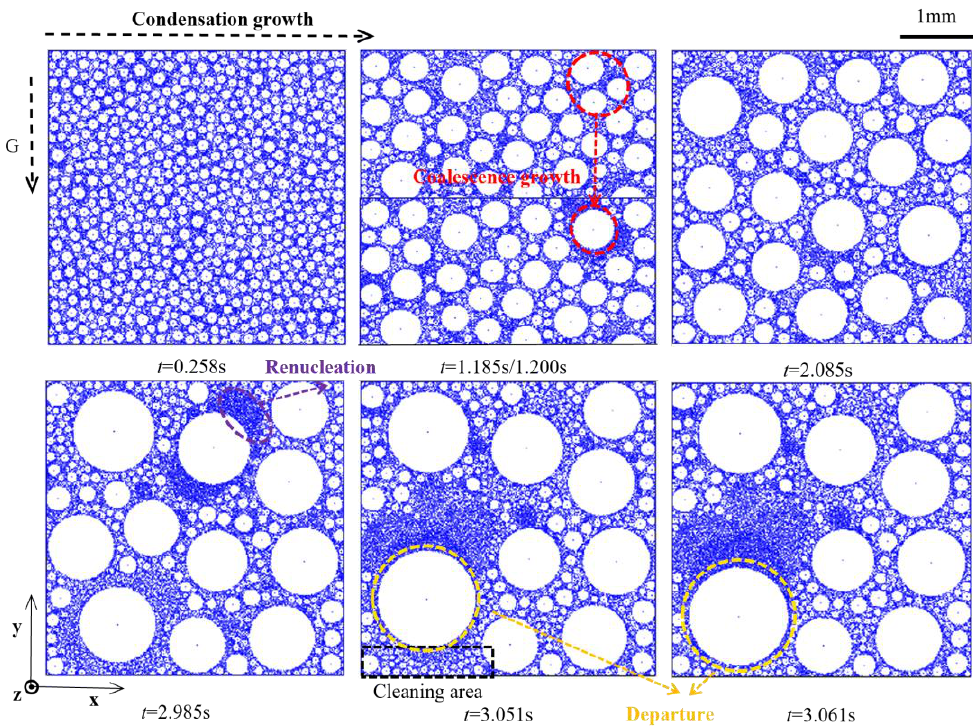
Figure 9. Evolution process of dropwise condensation on the vertical hydrophobic surface.